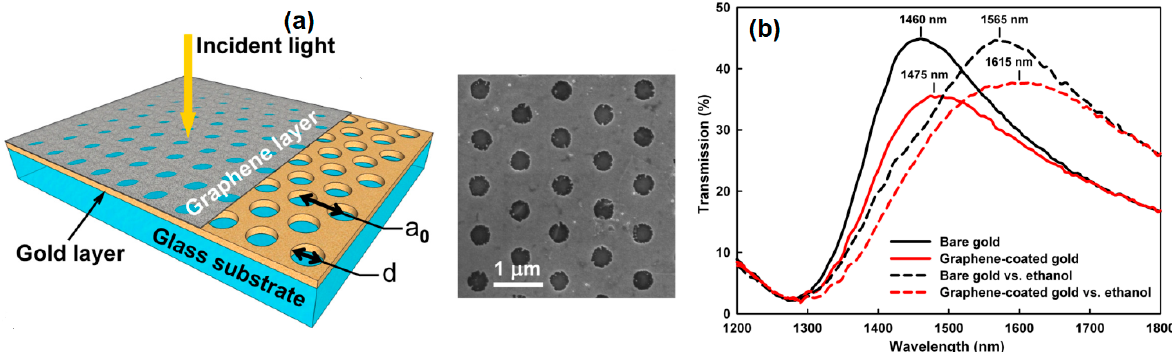
Figure 19. ( a ) Sketch of the developed SPR biosensor and SEM image results. ( b ) The response of the biosensor with bare gold and graphene coated gold after exposure to ethanol (Reproduced from [79], with the permission of AIP Publishing).